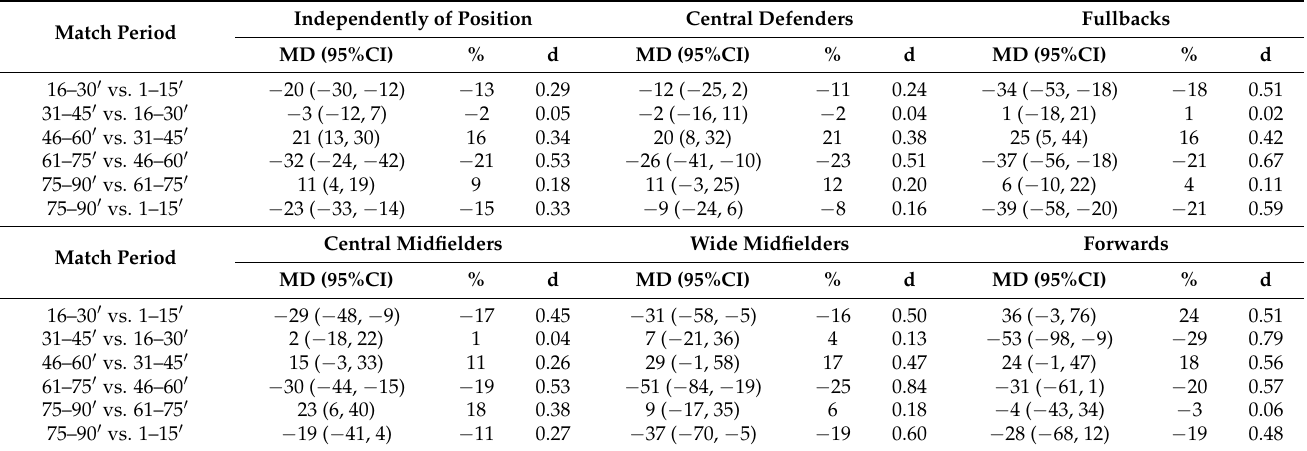
Table 4. Differences in high-intensity running between specific 15-min match